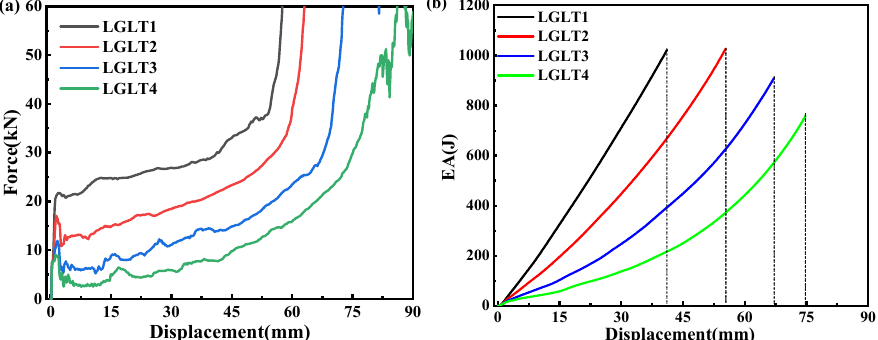
Figure 19. ( a ) Force–displacement curves ( b ) Energy absorption–displacement curves of four struc- tures under axial compression load. Table 9. Energy absorption parameters of LGLT models with different gradient configurations. Mass Samples